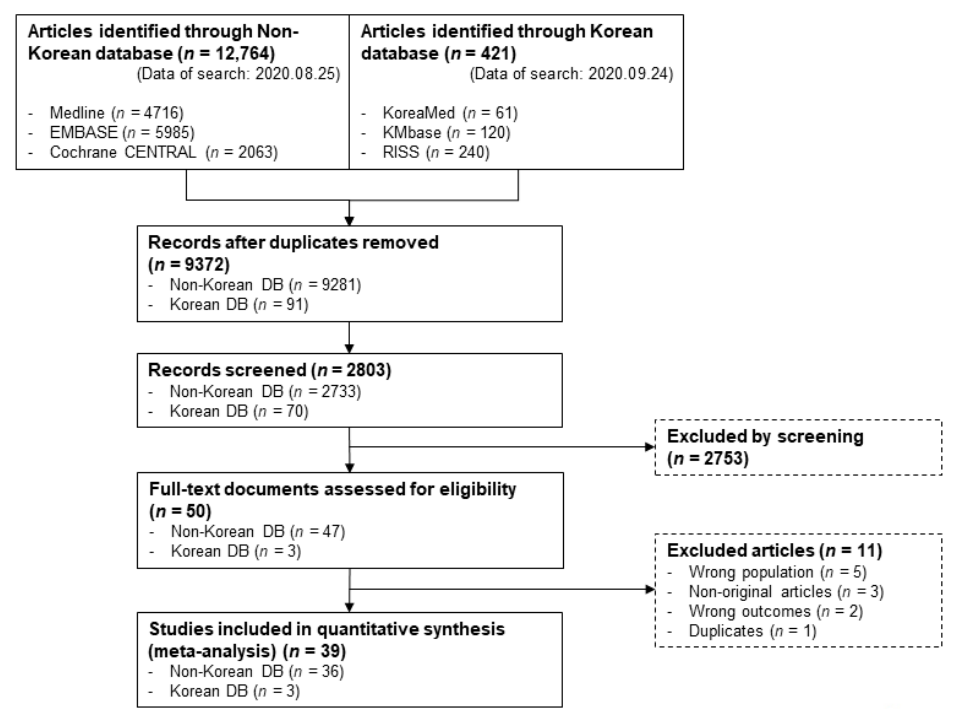
Figure 1. Literature search process for the systematic review and meta-analysis.